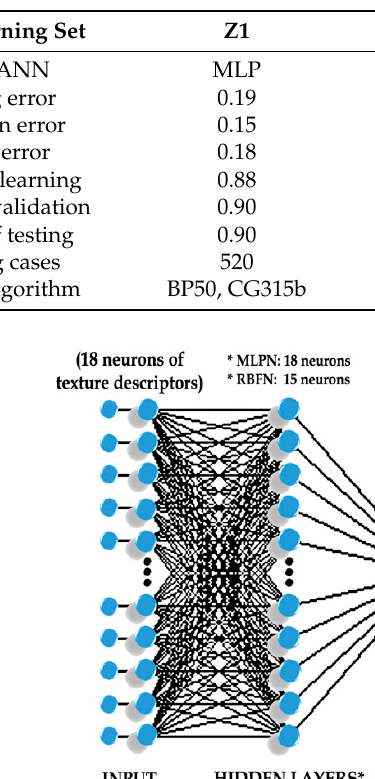
Table 1. Results of network learning.